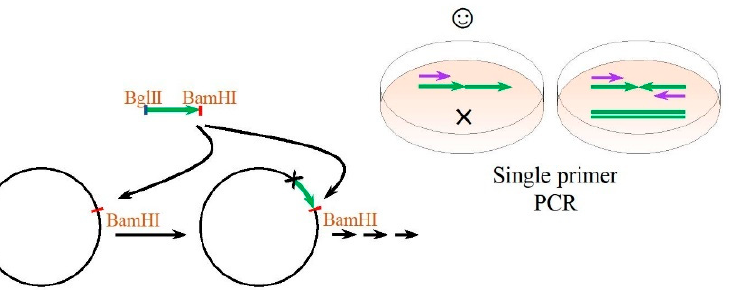
Figure 3. Principle scheme of cloning tandem repeats based on restriction/ligation of isocaudomers used in this work.